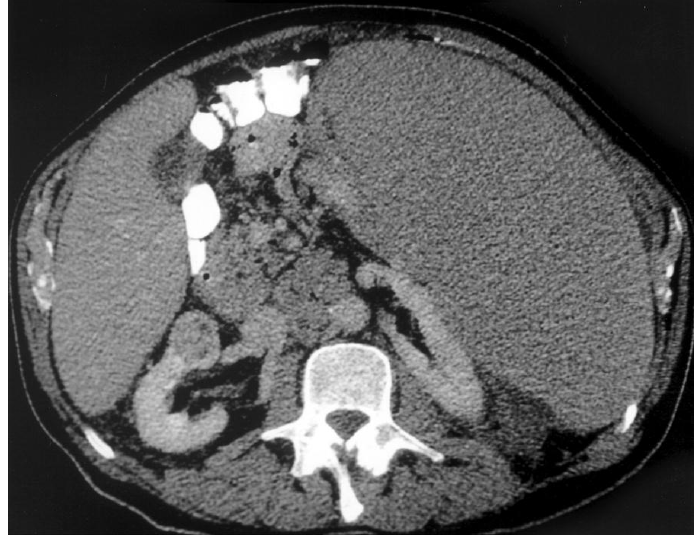
FIGURE 1. Preoperative abdominal CT scan demonstrating marked left renal compression secondary to massive splenomegaly and right renal